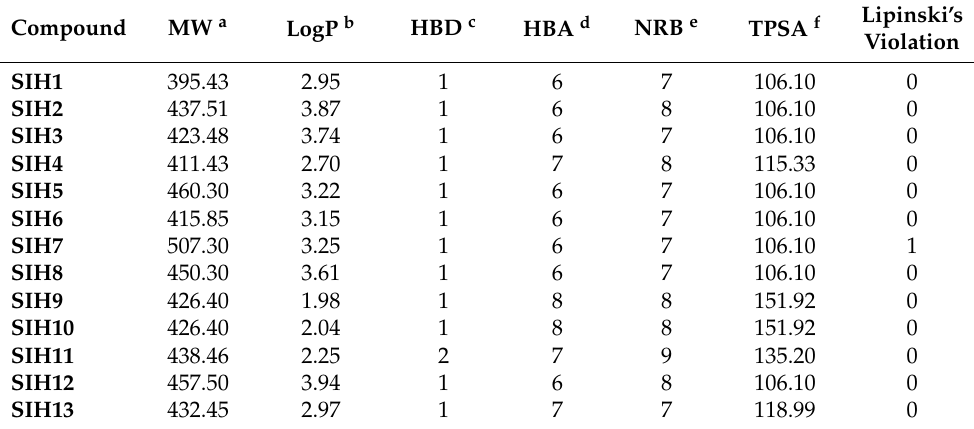
Table 3. Calculated molecular properties of SIH1–SIH13 .